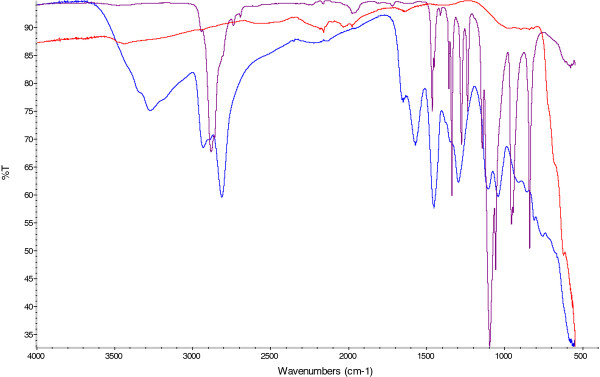
FTIR spectra of freeze dried MNP (red), MNP-PEI (blue) and MNP-PEI-PEG (purple) carried out on a Nicolet IS5 with and ID5 diamond tip ATR attachment. 64 scans were carried out for each sample.